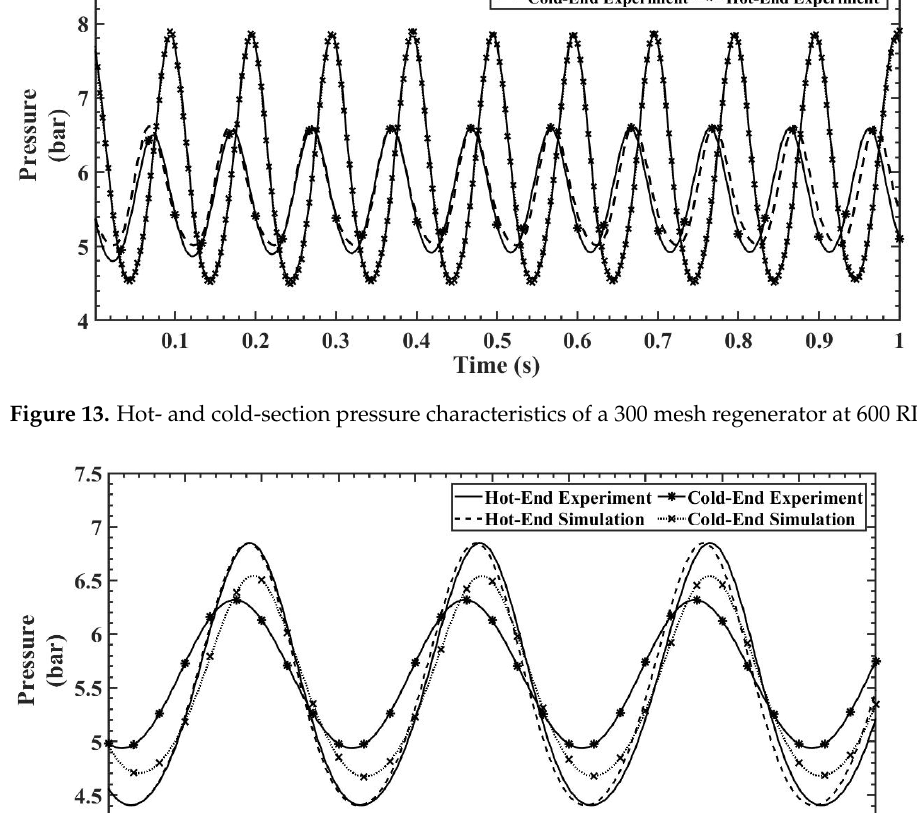
Figure 13. Hot- and cold-section pressure characteristics of a 300 mesh regenerator at 600 RPM.